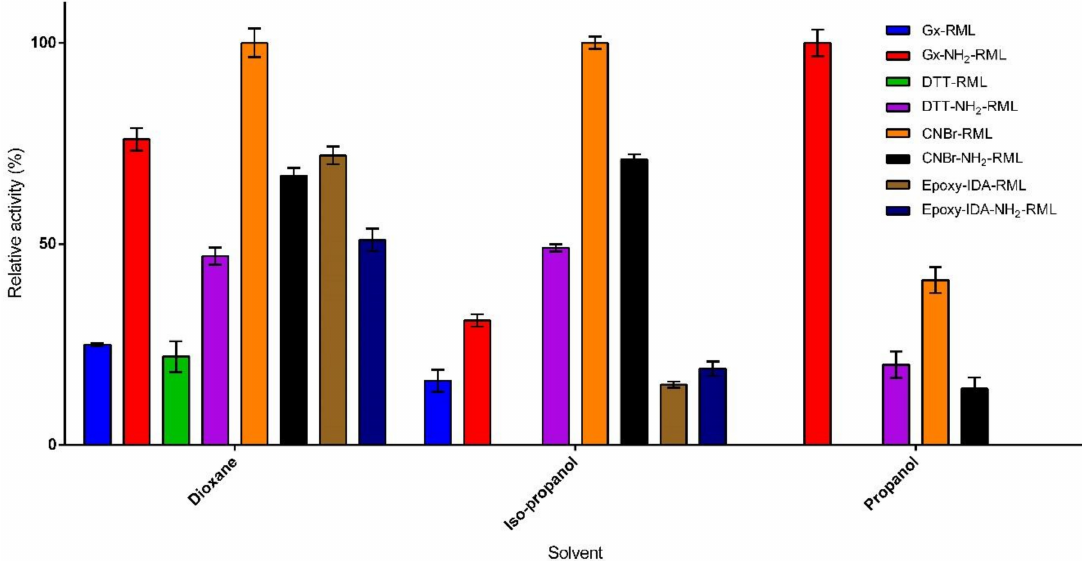
Figure 3. Co-solvent stability of the immobilized preparations in the presence of 20% of 1-propanol, 2-propanol, and dioxane at 25 ◦ C after 24 h